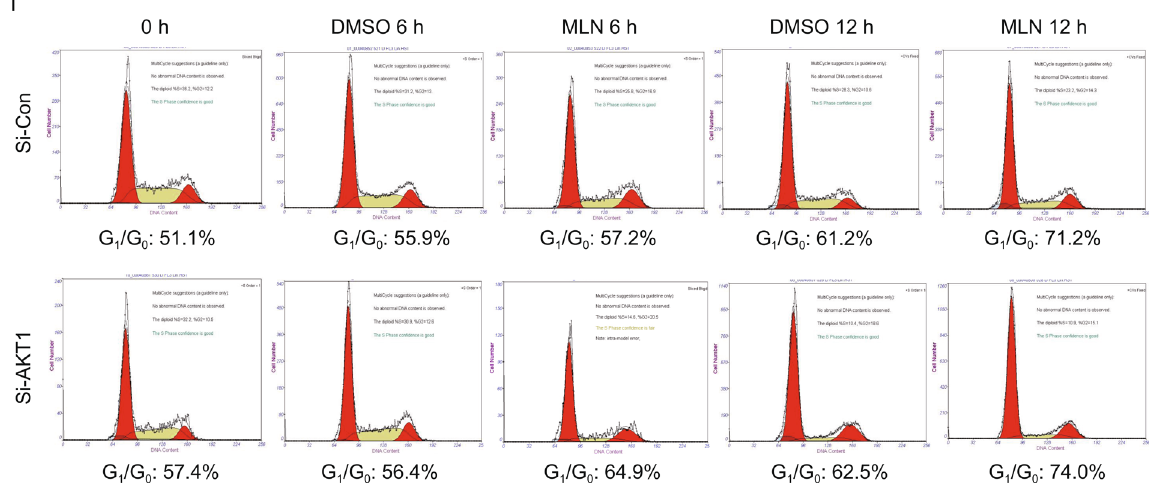
Figure 2. AKT activation plays a causal role in MLN4924- induced suppression of cilia initiation. (A – D) Effect of AKT1 activation on ciliogenesis: BEAS2B cells were cultured in normal serum containing medium (lane 1), then switched to serum starved condition (lanes 2 – 9) and treated with MLN4924 (0.3 μ mol/L) or MK2206 (1 μ mol/L) alone or in combination indicated periods of time, followed by western blotting with indicated Ab (A) or by immuno fl uorescence staining with anti- Arl13b and γ -tubulin ( γ -tub) antibodies, and photography (B). Percentage of ciliated cells were counted (C) or cilia length measured (D), and the results plotted. Shown is mean ± SEM from three independent experiments. ** P < 0.01. (E – H) Effect of AKT1 knockdown on cilia formation: BEAS2B cells were transfected with scrambled control siRNA or siAKT1, treated with DMSO or MLN4924 (0.3 μ mol/L) under serum starved condition for indicated periods of time, and Western blotting with indicated Abs (E) or immuno fl uoresence staining of cilia and photography (F). Percentage of ciliated cells were counted l (G) or cilia length measured (H) and the results plotted. Shown e C is mean ± SEM from three independent experiments. ** P < 0.01. (I ) AKT1 knockdown has no effect on the G0/G1 phase: & BEAS2B cells were transfected with scrambled control siRNA n or siAKT1, treated with DMSO or MLN4924 (0.3 μ mol/L) i e treatment under serum starved condition for cilia initiation, t o followed by FACS analysis. Shown are percentage of cells at r the G 0 /G 1 . P